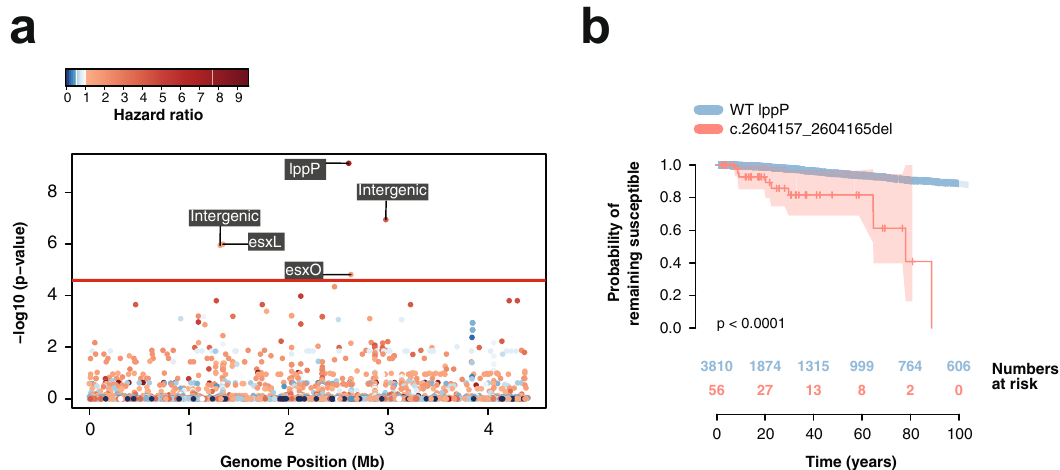
Fig. 7 Genome-Wide association study (GWAS) results. a Manhattan plot for GWAS on increased risk of drug resistance acquisition in lineage 4. The red line represents the Bonferroni corrected p -value threshold of 3.37×10 − 5 . Labels show the genes where the signi fi cant hits are located. Colors indicate the hazard ratio, with a scale of blue representing hazards ratio lower than 1 and a scale of reds for hazard ratios higher than 1. b Kaplan – Meier curve and numbers at risk of a 9 bp deletion in the gene lppP comparing the probability of remaining susceptible between those nodes without the deletion (blue) and those with it (red). Shaded areas represent the 95% CI. The p -value for the Kaplan – Meier curves was calculated using the log-rank